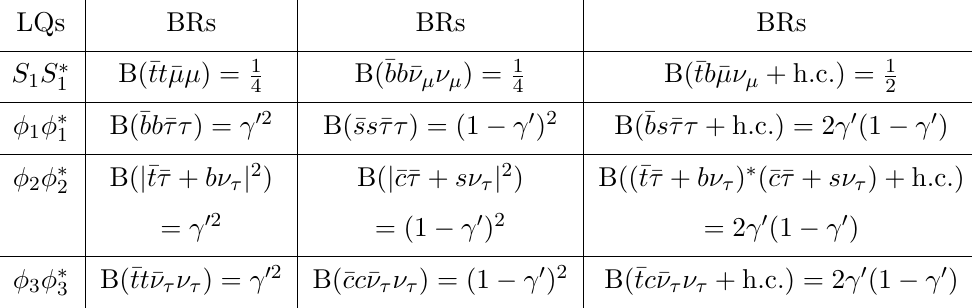
= ( (cid:20) 2 + (cid:20) 2 33 23 33